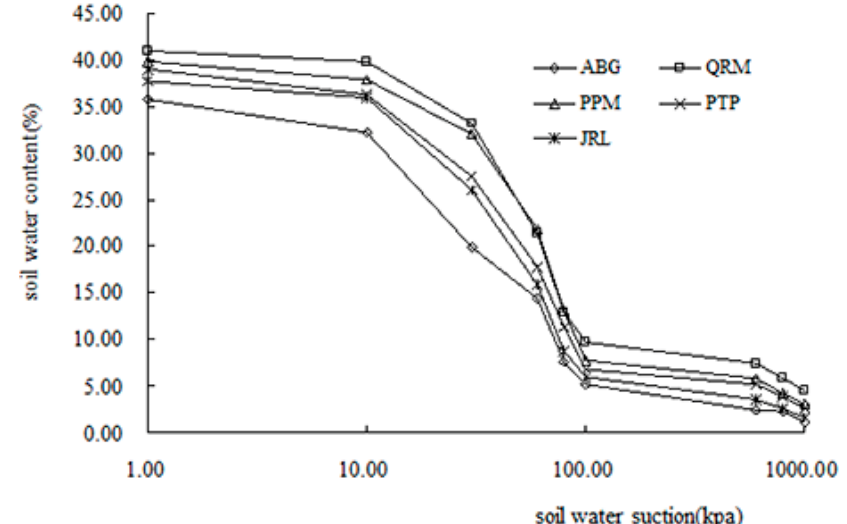
Figure 4. Soil WRC of the different vegetation types in the study area. QRM— Quercus Acutissima Carr. and Robina Pseudoacacia Linn. mixed plantation; PPM— Pinus thunbergii Parl. and Pistacia chinensis Bunge mixed plantation; PTP— Pinus thunbergii Parl.; JRL— Juglans rigia Linn.; ABG—Abandoned grassland.